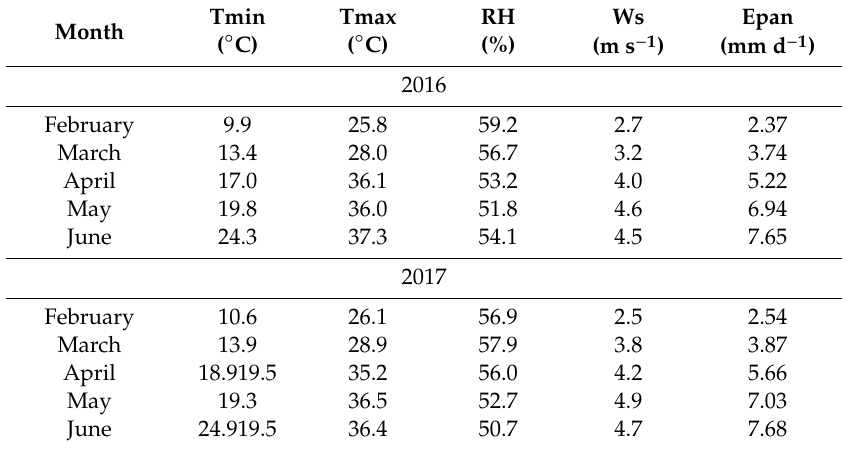
Table4. Maximumandminimumairtemperature, meanrelativehumidity, windspeed, andevaporation from Class A pan for two successive years (2016 and 2017).